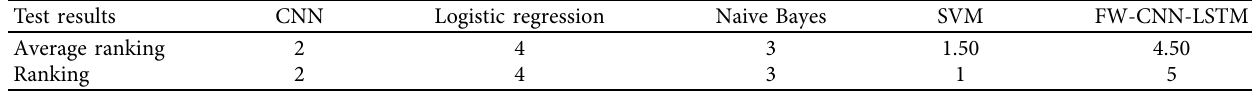
Table 10: Average ranking of Friedman’s test for the comparing algorithms of the IMDB dataset.